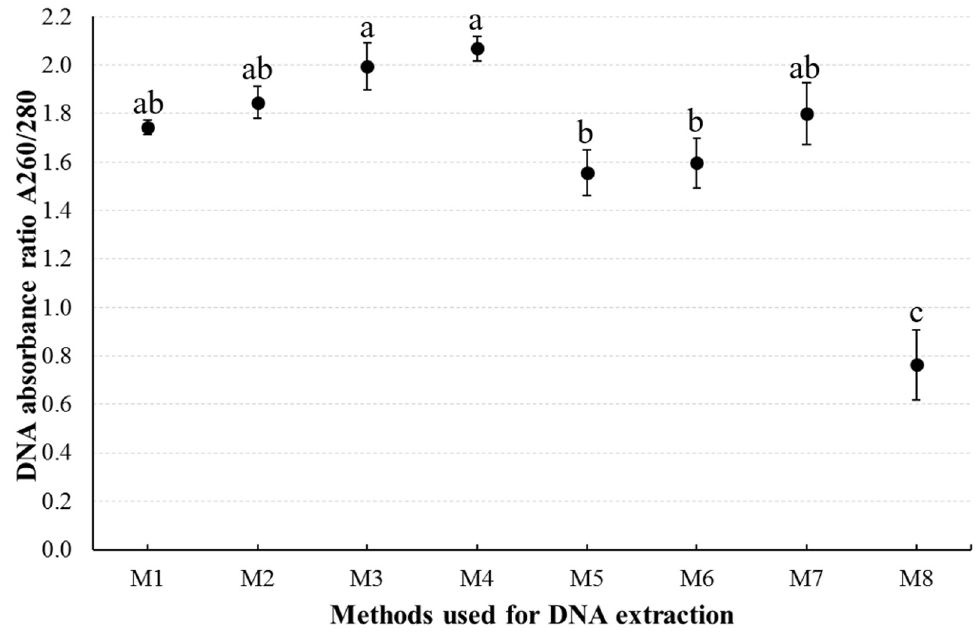
Fig 3. Average absorbance ratio A260/280 (mean ± SE) of DNA extracted from fresh and short period conserved samples. Average DNA absorbance ratio A260/280 was calculated based on samples of the 3rd instar female nymph and female adult. Means with different lowercase letters above the bars are significantly different at P < 0.05 (one-way ANOVA, Tukey’s HSD test).